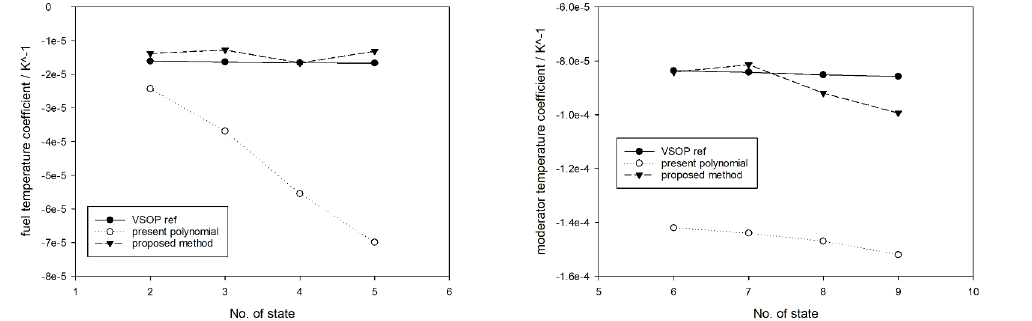
Figure 6. Comparison of temperature coefficient results in different